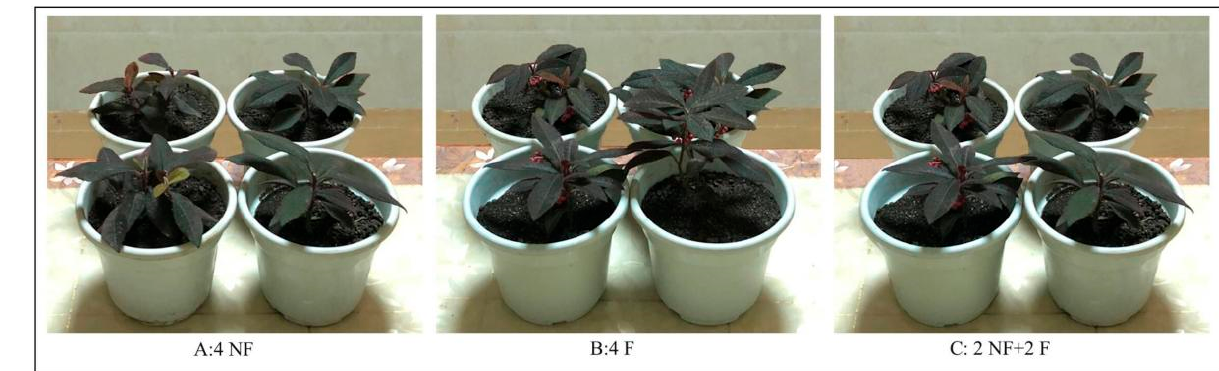
Figure 1. Ardisia mamillata Hance ( A ): 4 NF, ( B ): 4 F, ( C ): 2 NF + 2 F.